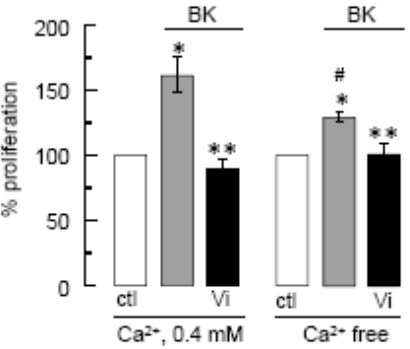
Figure 4. Impact of extracellular Ca 2+ on BK-induced BUVEC proliferation and on the inhibitory effect of